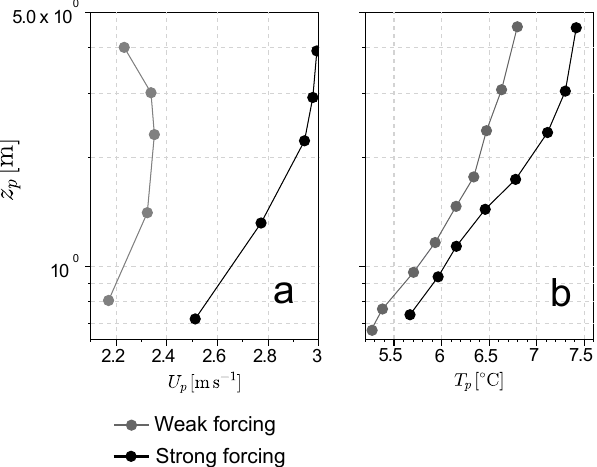
Figure 5. (a) Median wind-speed profiles and (b) temperature pro- files during the 2009 field campaign for (grey) WF conditions and (black) SF